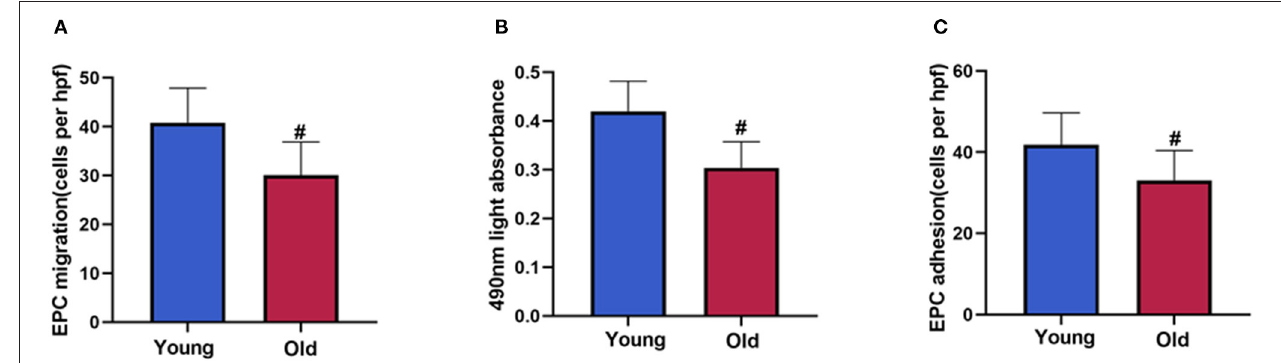
FIGURE 1 | EPC function between young and old-aged group. The circulating EPC migration (A) , proliferation (B) , adhesion (C) decreased in old-aged patients with NSTEMI compared with young patients. Data are given as mean ± SD. # P < 0.05 vs. young